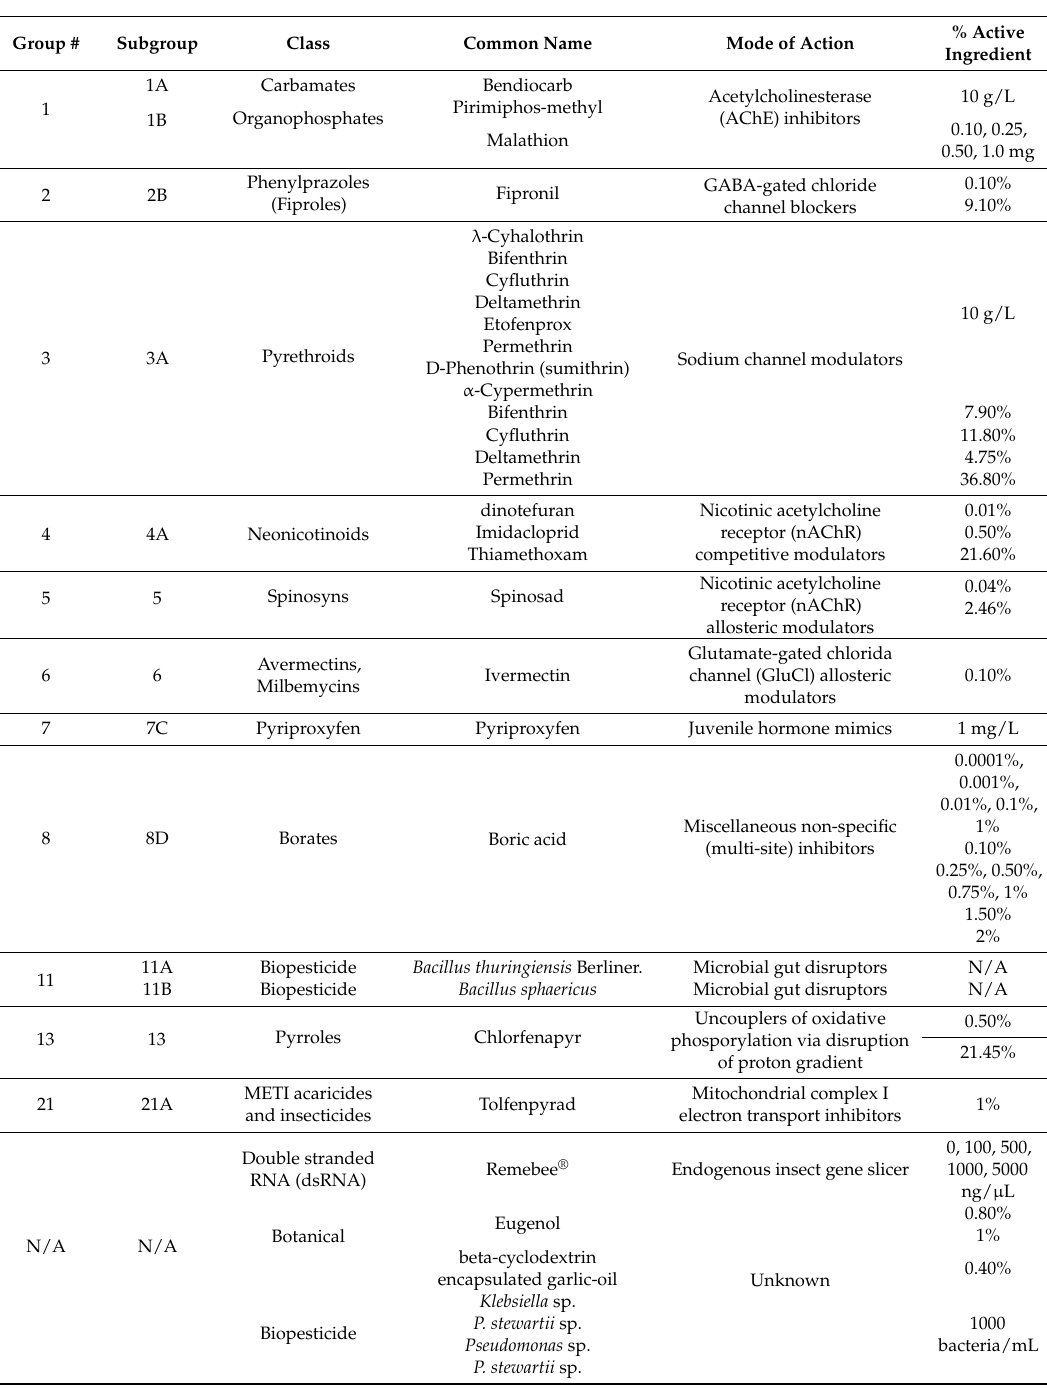
Table 1. Active ingredients (AI) and percent AI incorporated into toxic sugar baits and attractive toxic sugar baits for adult mosquito control, by group, subgroup, class, common names, and mode of action (MOA) as indicated by the Insecticide Resistance Action Committee (IRAC)